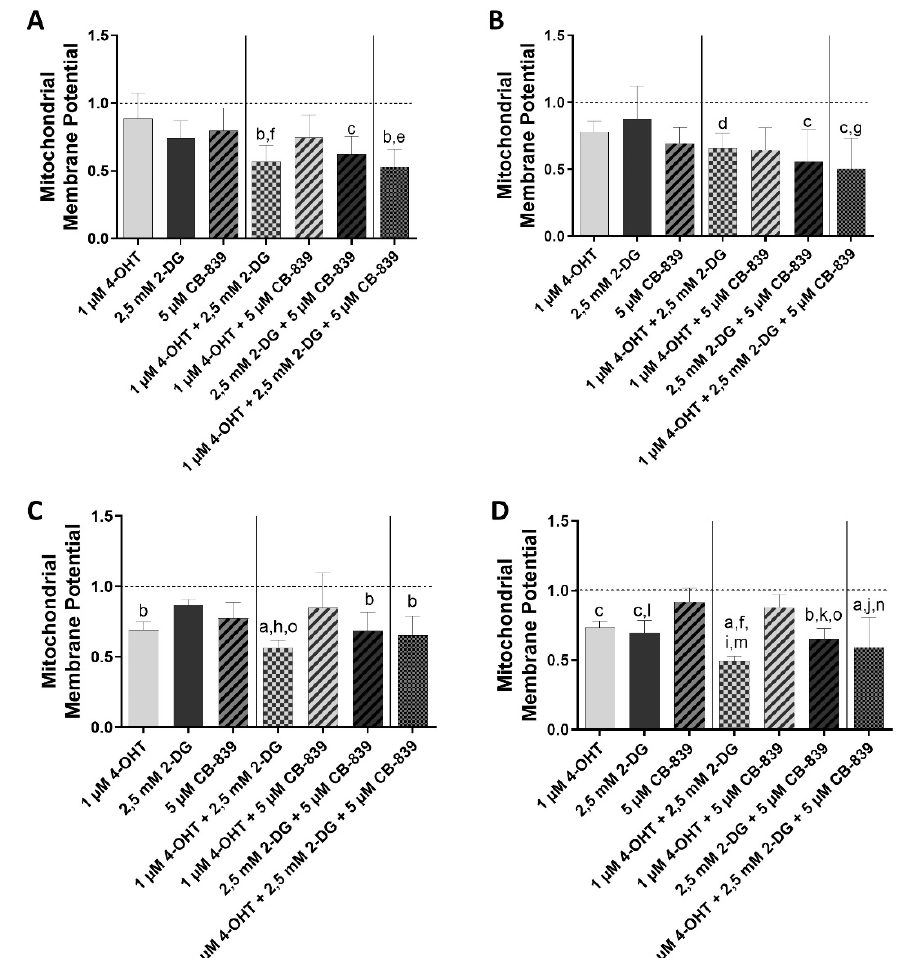
Figure 3. Mitochondrial membrane potential of human breast cancer cell lines MCF7 ( A ), T47D ( C ) and their tamoxifen-resistant sublines MCF7-TR ( B ) and T47D-TR ( D ) after treatment with or without 4-OHT, 2-DG or CB-839 or different combinations. Columns represent means ± SEM of data obtained from three independent experiments in three different passages of the cell lines. a, p < 0.0001 vs. control; b, p < 0.001 vs. control; c, p < 0.01 vs. control; d, p < 0.05 vs. control; e, p < 0.01 vs. 1 µ M 4-OHT; f, p < 0.05 vs. 1 µ M 4-OHT; g, p < 0.05 vs. 5 mM 2-DG; h, p < 0.001 vs. 2.5 mM 2-DG; i, p < 0.0001 vs. 5 µ M CB-839; j, p < 0.001 vs. 5 µ M CB-839; k, p < 0.01 vs. 5 µ M CB-839; l, p < 0.05 vs. 5 µ M CB-839; m, p < 0.0001 vs. 1 µ M 4-OHT + 5 µ M CB-839; n, p < 0.01 vs. 1 µ M 4-OHT + 5 µ M CB-839; o, p < 0.05 vs. 1 µ M 4-OHT + 5 µ M CB-839 (ANOVA followed by Tukey’s multiple comparisons